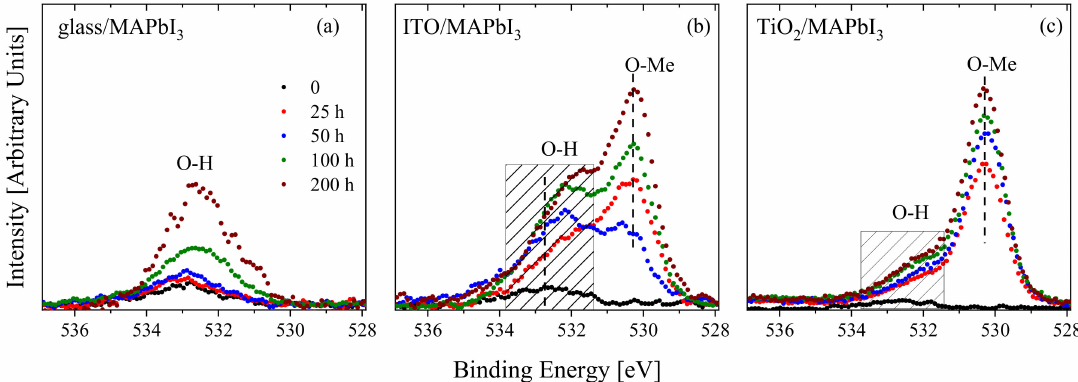
Figure 8. XPS Pb O 1s spectra of light-soaked MAPbI 3 hybrid perovskites prepared on different substrates: ( a ) glass, ( b ) ITO, and ( c ) TiO 2 substrates.